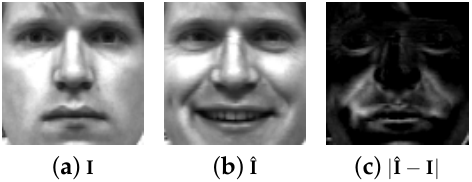
Figure 2. ( a ) Neutral image; ( b ) variational image; ( c ) absolute difference between neutral and variational image.